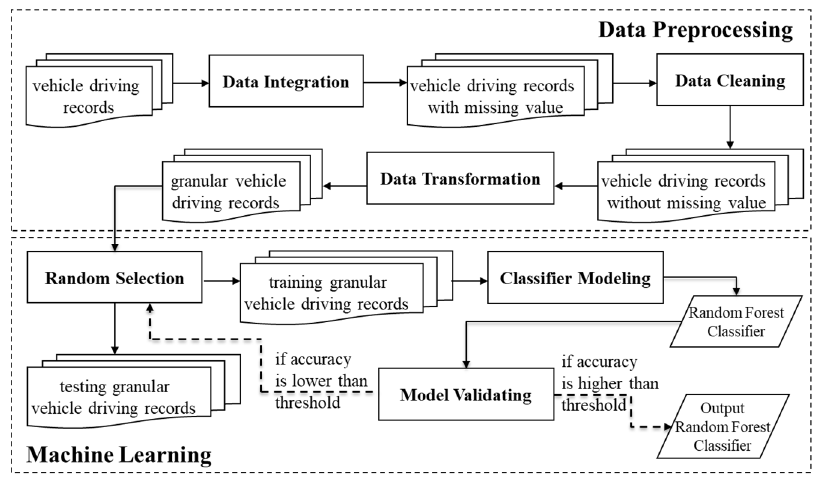
Figure 1. Work flow of our proposed method.